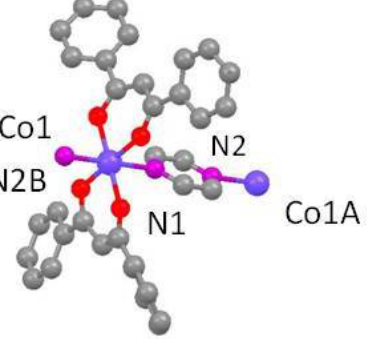
Figure 1. Ball-and-stick model of trans -[Co(DBM) polymer chain. The hydrogen atoms are not included for clarity (C, gray; Co, blue; N, purple; O, red).